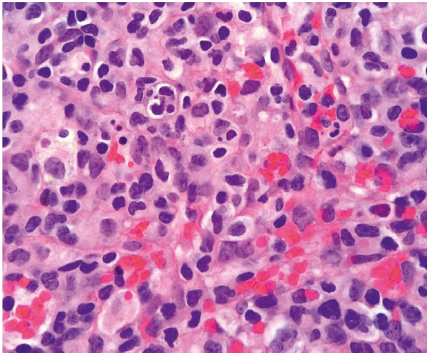
Figure 1: H&E of left supraclavicular lymph node at 100x demonstrating hemophagocytosis with apoptotic debris.